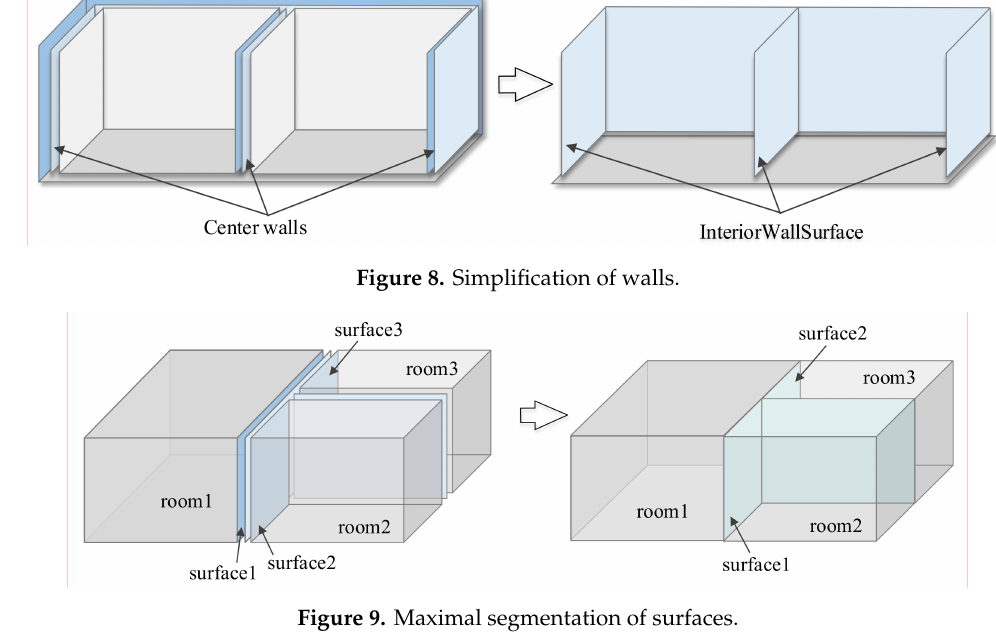
Figure 9. Maximal segmentation of